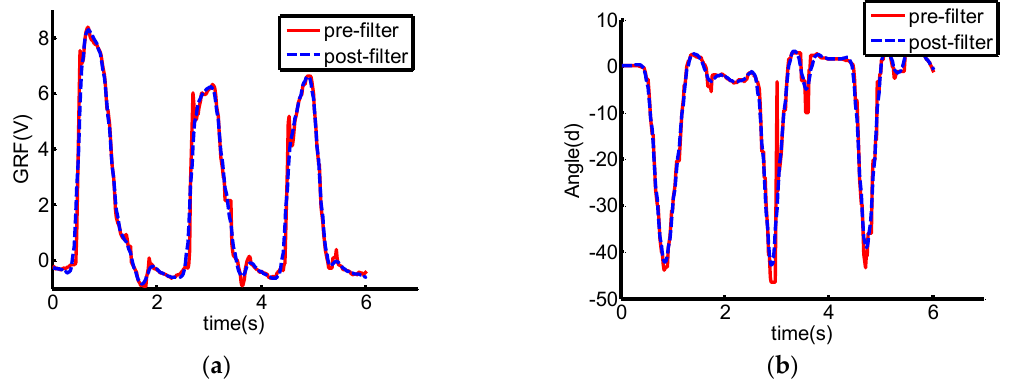
Figure 6. Signal curves comparison between pre-filter and post-filter. Signals through filter are smoother. ( a ) GRF curves from the sensor placed on the heel; ( b ) Inclination angle curves from the AHRS on the foot.